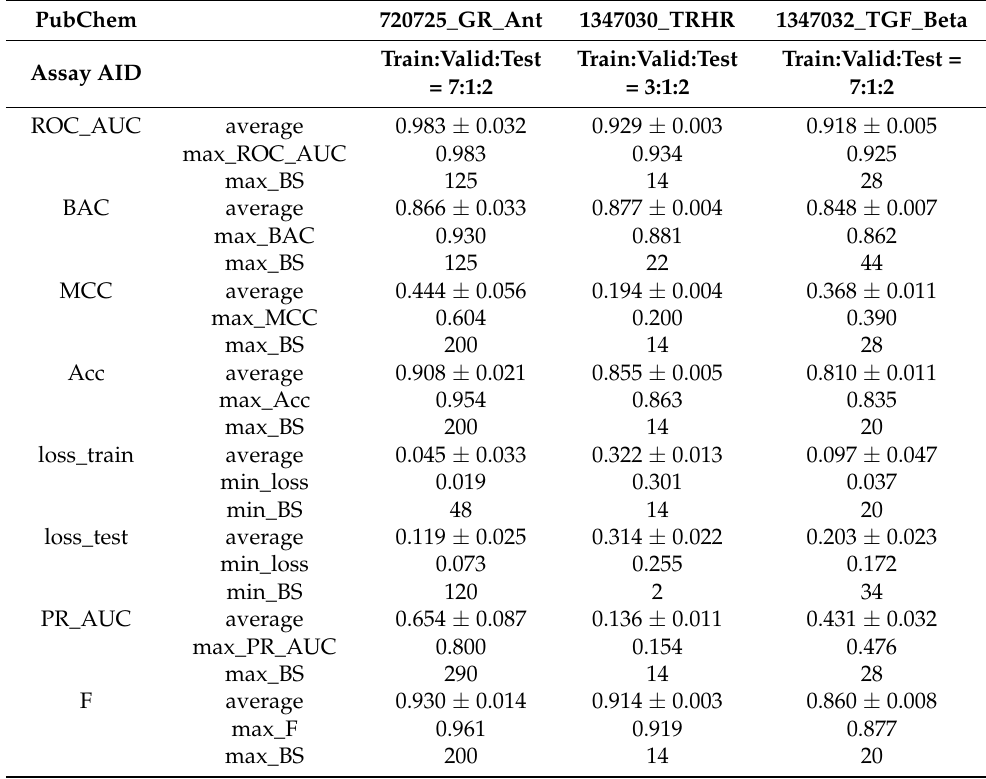
Finally, to investigate the effect of BS in the improved DeepSnap-DL with Python sys- tem on prediction-performance values, we optimized 84 BSs from 2 to 300 in 720725_GR_ant, 13 LRs from 2 to 26 in 1347030_TRHR_ago, and 37 LRs from 2 to 80 in 1347032_TGF_beta_ant using the valid dataset (Table S3). The mean ROC_AUC, BAC, MCC, and Acc values in the test dataset were 0.983 ± 0.032 for ROC_AUC in 720725_GR_ant, 0.929 ± 0.003 for ROC_AUC in 1347030_TRHR_ago, 0.918 ± 0.005 for ROC_AUC in 1347032_TGF_beta_ant, 0.866 ± 0.033 for BAC in 720725_GR_ant, 0.877 ± 0.004 for BAC in 1347030_TRHR_ago, 0.848 ± 0.007 for BAC in 1347032_TGF_beta_ant, 0.444 ± 0.056 for MCC in 720725_GR_ant, 0.194 ± 0.004 for MCC in 1347030_TRHR_ago, 0.368 ± 0.011 for MCC in 1347032_TGF_beta_ant, and 0.908 ± 0.021 for Acc in 720725_GR_ant, 0.855 ± 0.005 for Acc in 1347030_TRHR_ago, 0.810 ± 0.011 for Acc in 1347032_TGF_beta_ant, respectively (Table 5). Table 5. Performances with LRs using DeepSnap_python system of the three MIE targets. PubChem